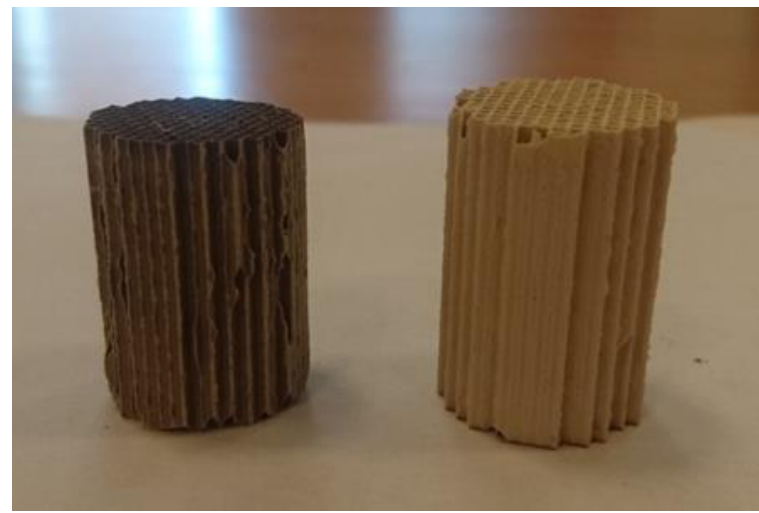
The used contaminant removal procedures are described in Table 1.